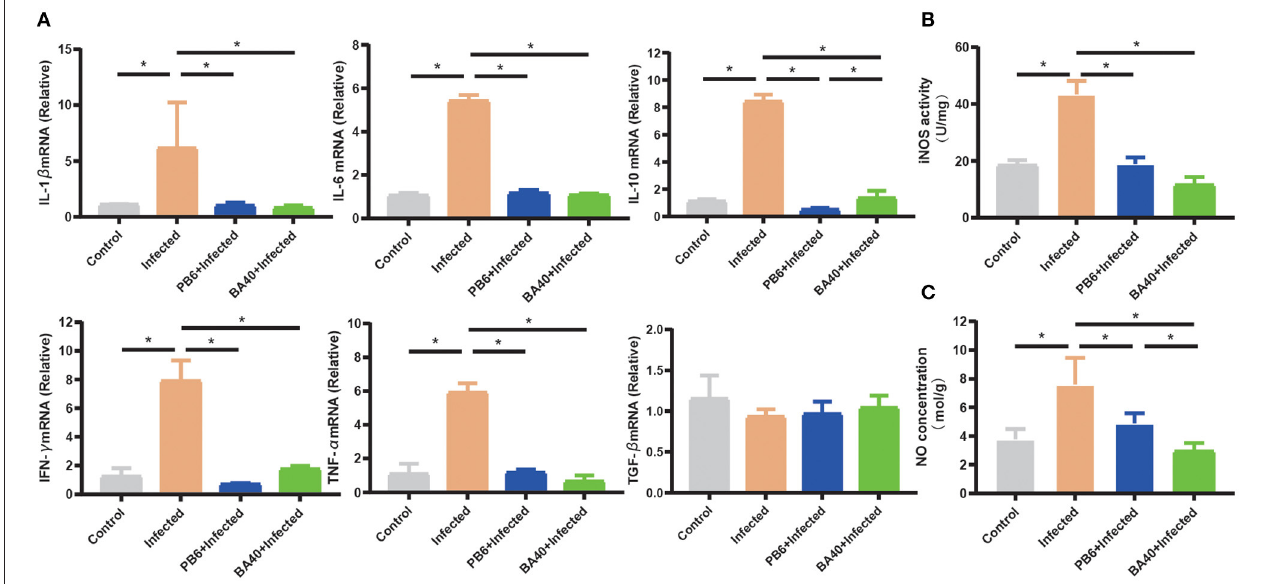
FIGURE 5 | BA40 down-regulated inflammatory response. (A) Cytokines gene expression determined by the RT-qPCR. The inducible nitric oxide synthase (iNOS) activity (B) and nitric oxide (NO) production (C) in the jejunal mucosa were measured using an enzyme-linked immunosorbent assay (ELISA) kit. The results are presented as mean ± SD ( n = 6/group, *represented significant differences P < 0.05).